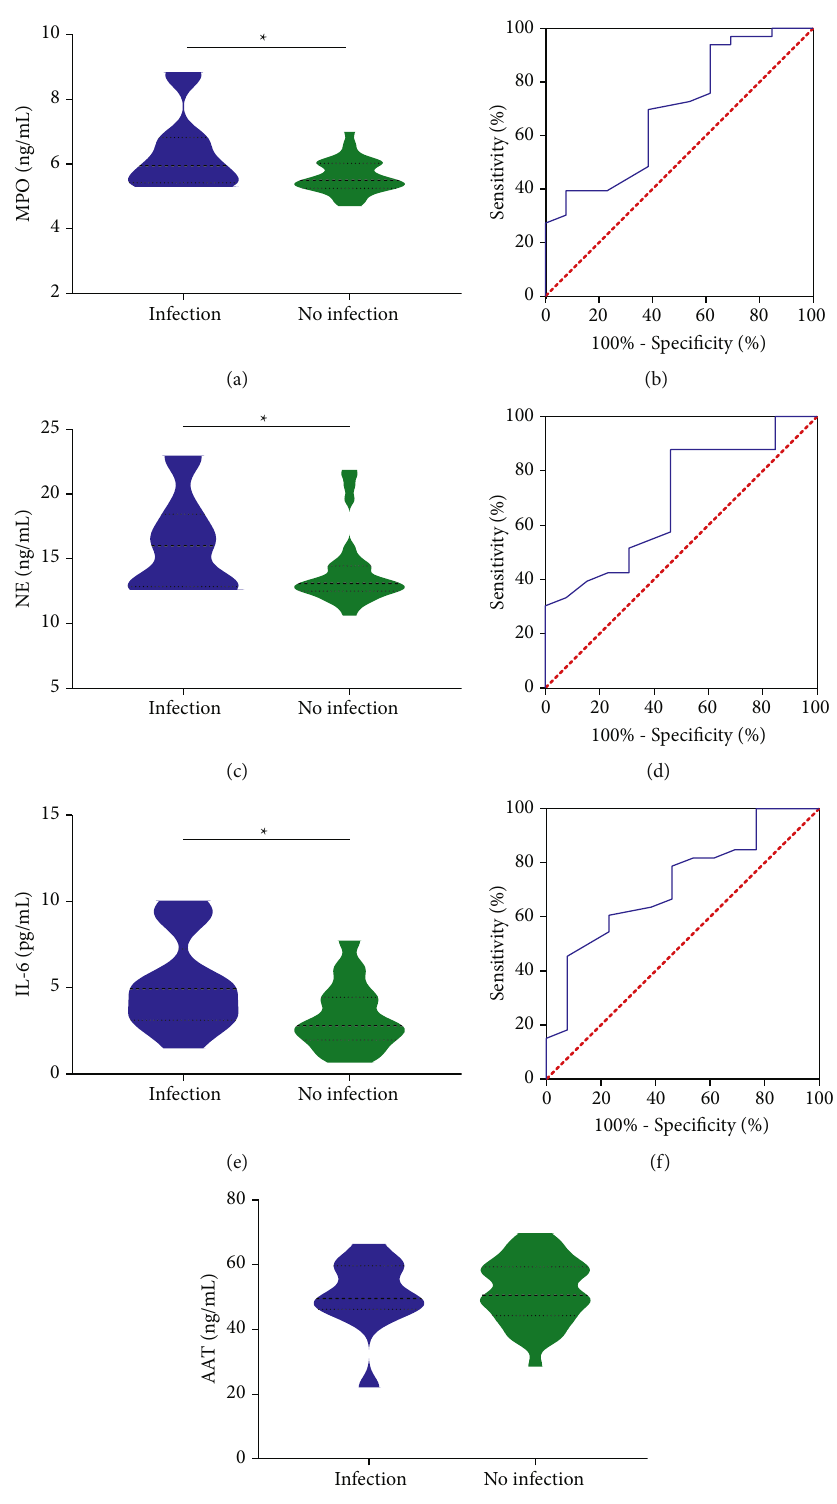
Figure 3: MPO, NE, and IL-6 in respiratory infections of IIM patients. In the ASS and DM patients with respiratory infections compared to patients without respiratory infections, MPO (a) ( P = 0 : 049 ), NE (c) ( P = 0 : 049 ), and IL-6 (e) ( P = 0 : 014 ) were signi fi cantly higher. ROC analysis showed that the AUC values of MPO (b) at 0.692 (95% CI 0.523 – 0.861, P = 0 : 044 ), NE (d) at 0.692 (95% CI 0.5251 – 0.859, P = 0 : 044 ), and AUC values of IL-6 (f) at 0.720 (95% CI 0.561 – 0.880, P = 0 : 021 ). (g) AAT was not signi fi cantly di ff erent in the two groups of